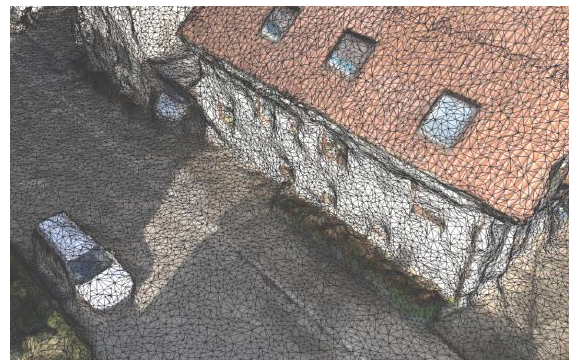
Figure 2 . Enlarged section of the test